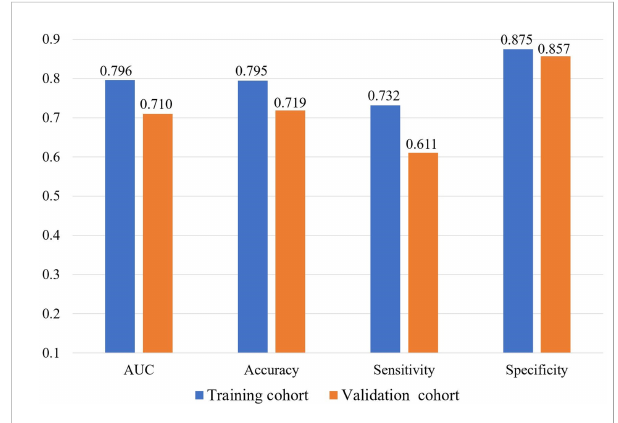
FIGURE 4 Performances of the fi nal LR model for predicting the localized nephroblastoma.